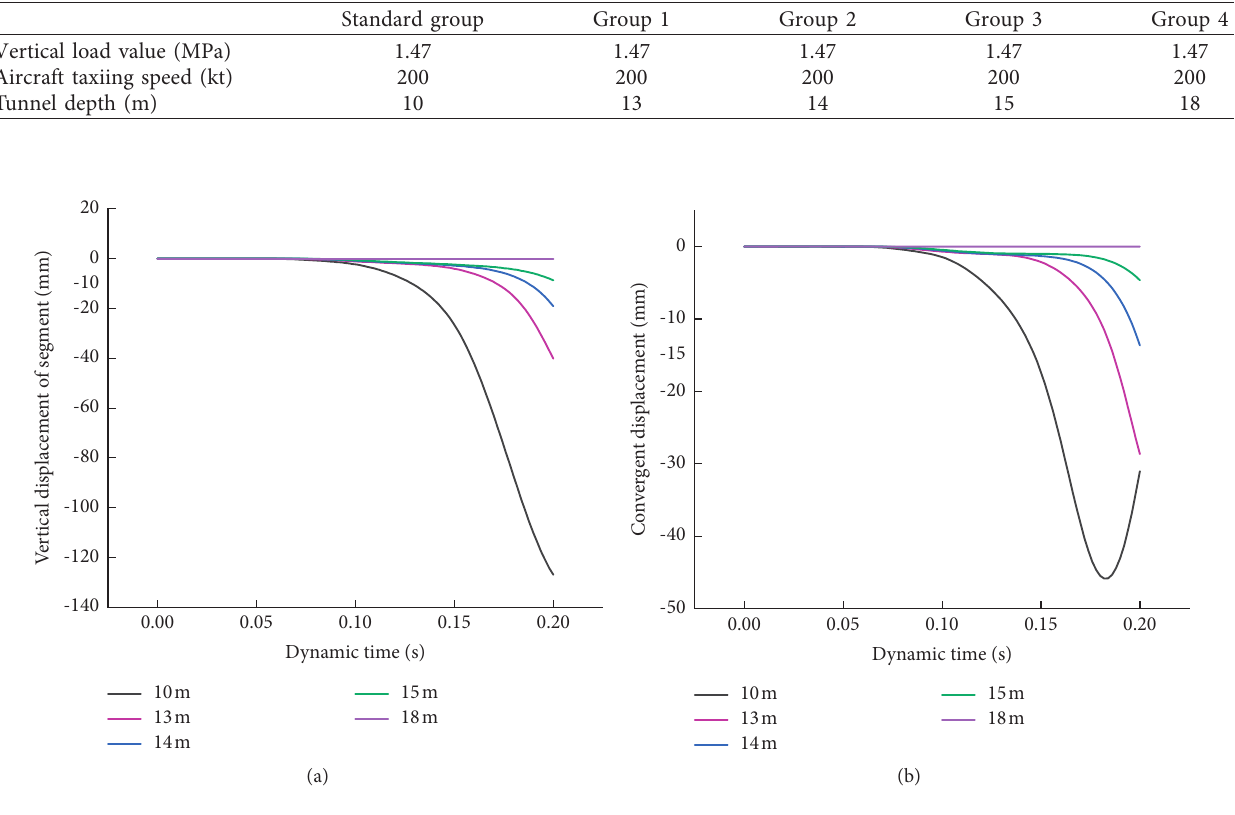
Figure 11: Time-history curves of deformation response of tunnel segments under different tunnel depths. (a) Vertical displacement of a segment. (b) Convergent displacement of a